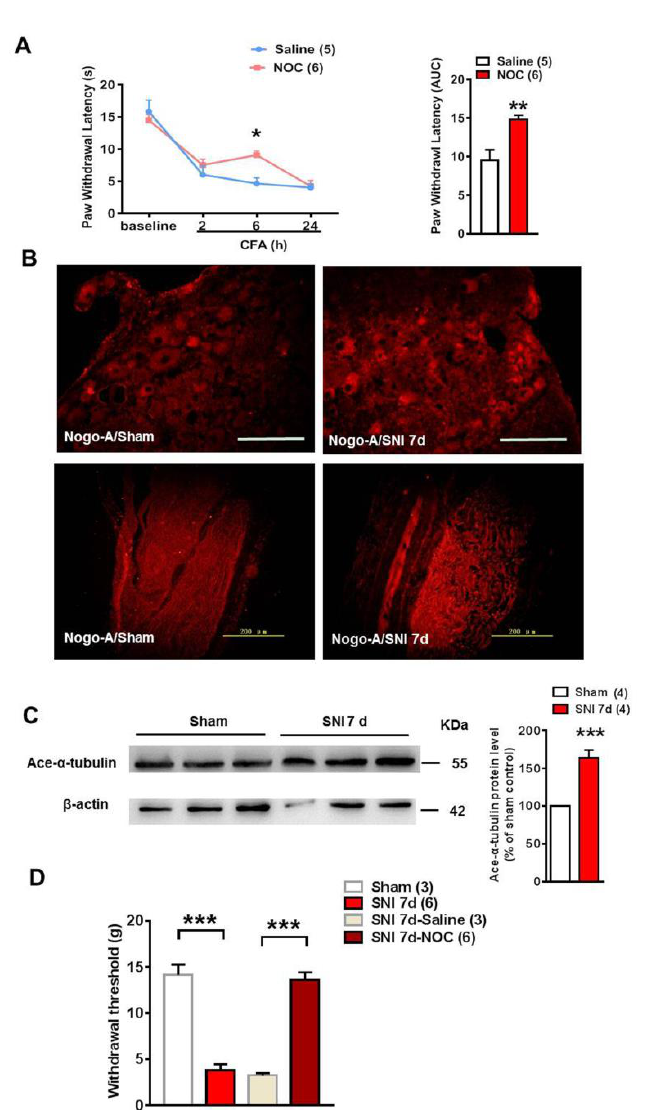
Figure 5. Inhibition of microtubule polymerization with nocodazole (NOC) attenuated signifi- cantly the CFA-induced inflammatory heat hyperalgesia and the mechanical pain in SNI. ( A ) Pre-intrathecal injection of 3.0 mg/kg NOC significantly elevated the PWL of rats after CFA ad- ministration. Time course of PWL and quantification analysis of the area under the curve (2 – 24